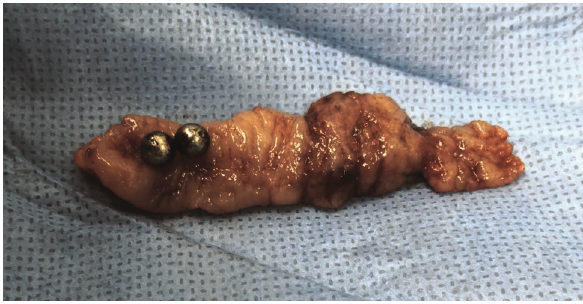
Fig. 4 Perioperative fi nding: an incised appendix vermiformis con- taining two MFBs. MFBs, magnetic foreign